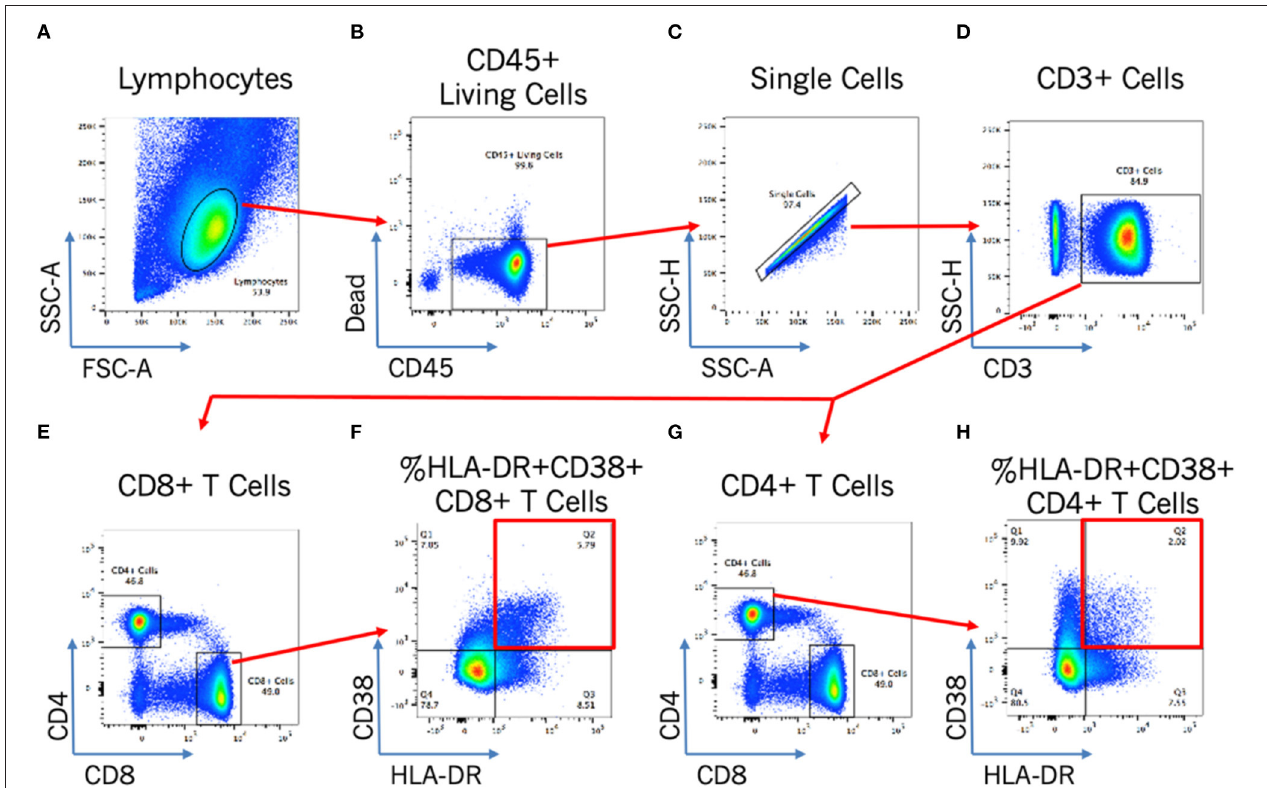
FIGURE 2 | Flow cytometry gating strategy for T cell activation analysis. Flow cytometry gating strategy to identify by morphology and/or stain: lymphocytes (A) ; CD45 + living cells (B) ; single cells (C) ; CD3 + cells (D) ; and CD4 + or CD8 + activated cells [by HLA-DR + CD38 + ; (E–H)